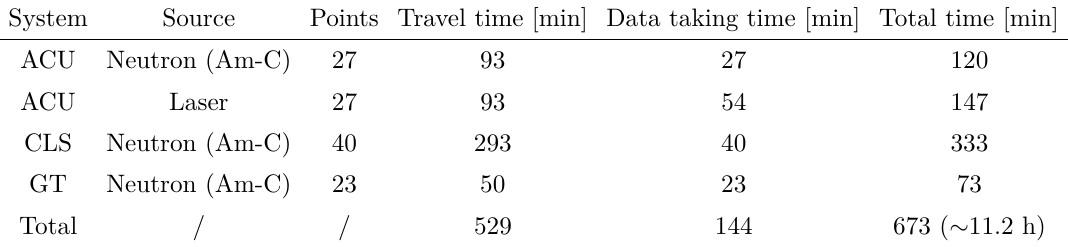
Table 7 . Monthly calibration with ACU, CLS and